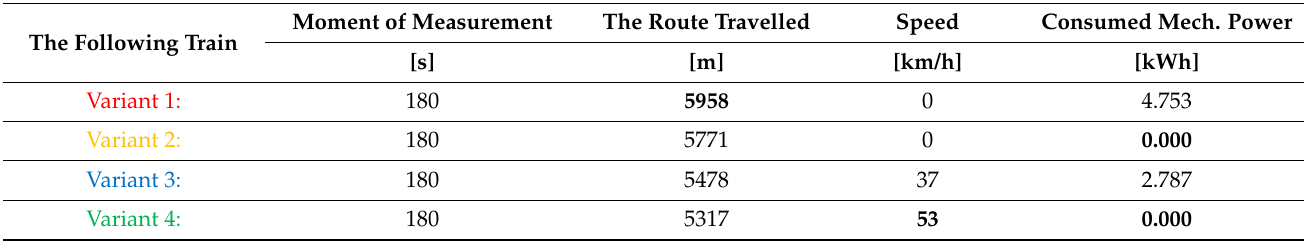
Table 2. Results for the variants P N according to Context 1 P P .